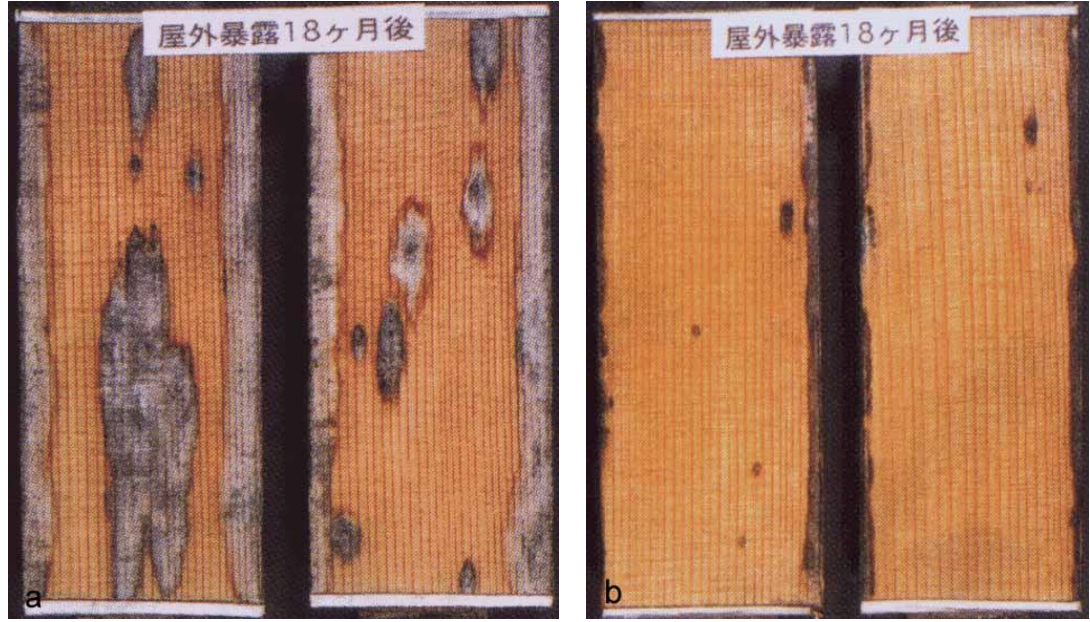
Figure 11. Effects of grafting the epoxy-functionalized UV absorber, 2-hydroxy-4(2,3- epoxypropoxy)-benzophenone on the performance of an acrylic silicone clear coating on sugi wood: ( a ) Unmodified wood; ( b ) Wood treated to a weight gain of 5.6%. Unmodified and treated and coated panels were exposed to the weather for 18 months in Tsukuba,